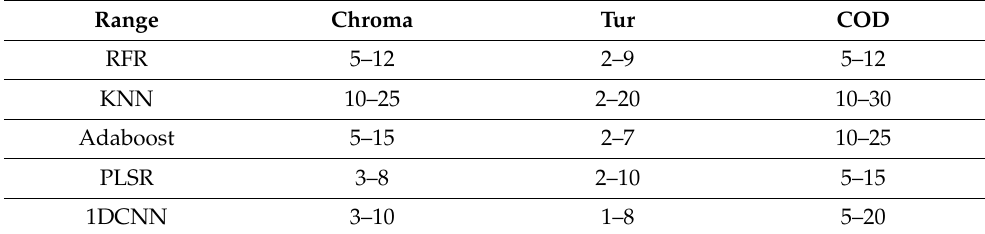
Table 3. The range of parameter α for different regression models. Range Chroma